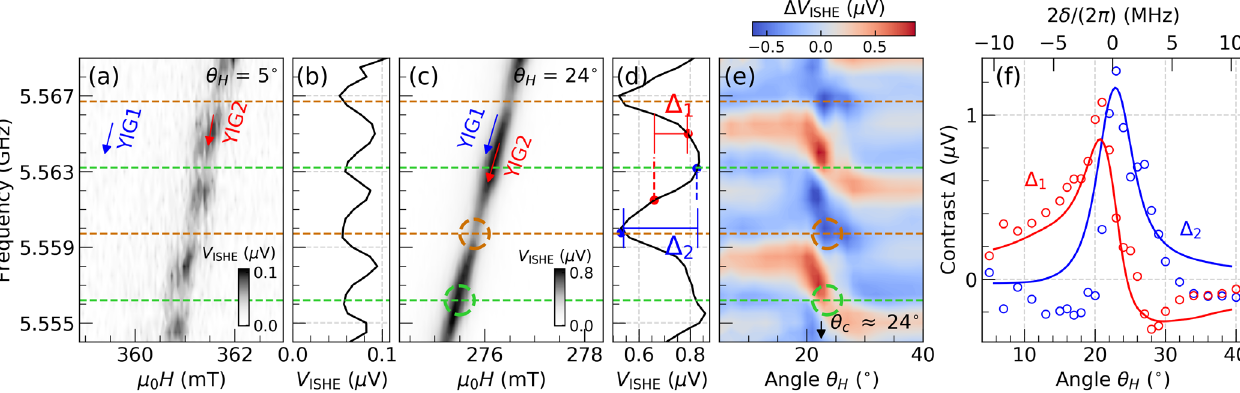
FIG. 4. (a),(c) Gray-scale plot of the voltage signal V generated by the Pt contact on YIG2 as a function of microwave frequency ISHE and magnetic field with tilt angles (a) θ H ¼ 5 ° and (c) θ H ¼ 24 ° (microwave power is set at 6 dBm). The blue arrow indicates the location of the Kittel mode of YIG1. (b),(d) show the voltage modulation along the YIG2 resonance. The contrasts Δ 2 (blue) and Δ 1 (red) in (d) are the voltage drops measured at the crossings between two consecutive phonon lines (blue dots) and at the middle of the crossings of two phonon lines (red dots), respectively, for θ H ¼ 24 °. (e) Color-scale plot of V as a function of the frequency and polar ISHE angle. Here, we subtract a constant background and correct for the angular dependence of the spin Hall effect (see the text), where red (blue) indicates a positive (negative) value. (f) The two different signals Δ 1 and Δ 2 defined in (d) are plotted as a function of θ H . The solid lines are the expectations from the